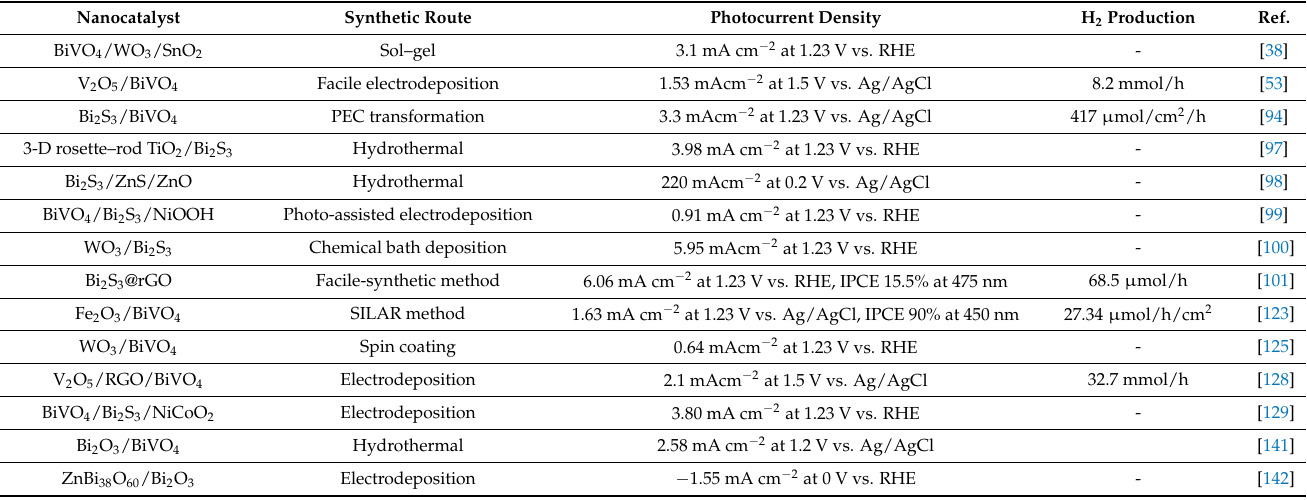
Table 2. PEC efficiency of Bi-based heterostructured nanocatalysts for HER performances.